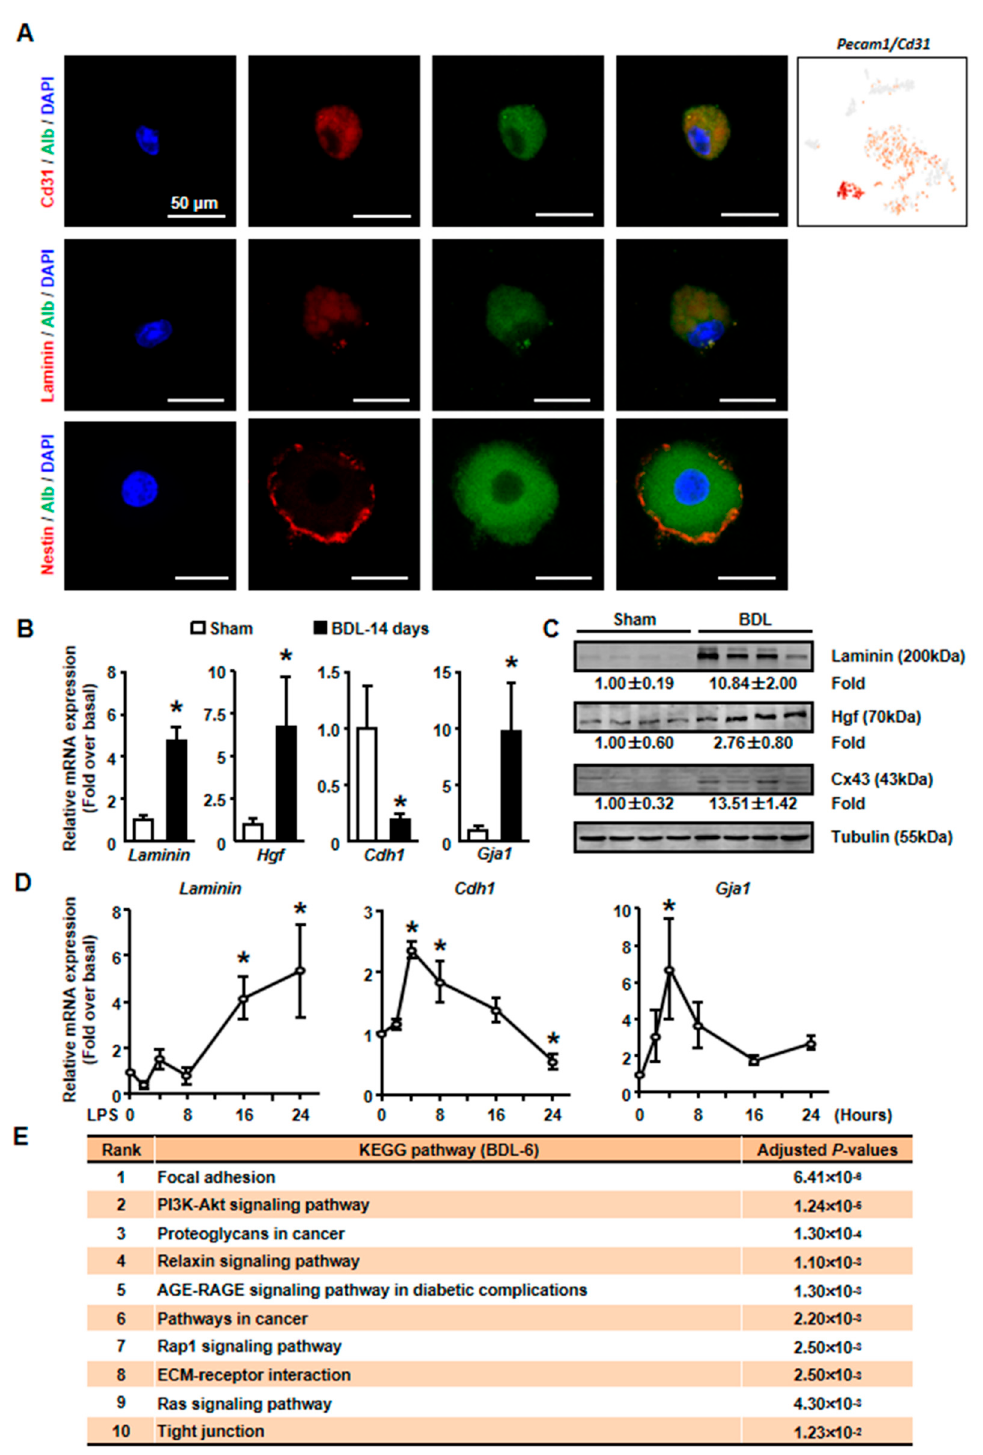
Figure 5. The expressions of tissue repair-related genes were changed in isolated cholestatic hepatocyte. ( A ) The detection of Alb and CD31, Laminin, Nestin on cholestatic hepatocyte smear. Scale bars, 50 µ m. ( B ) The mRNA expressions of representative tissue repair-related genes were examined in isolated normal and cholestatic livers. ( C ) Western blot was employed to study the protein level of tissue repair-related genes. ( D ) Isolated normal hepatocytes were cultured with 100 ng / mL LPS and the mRNA expression of Laminin, E-cadherin and Cx43 were detected by qPCR. ( E ) Pathway analysis of top 200 high expressed genes of BDL-6. Data are presented as the means ± SEM. * p < 0.05 vs. control ( n = 7 for each group in Figure 5B, n = 3 for each group in Figure 5D).